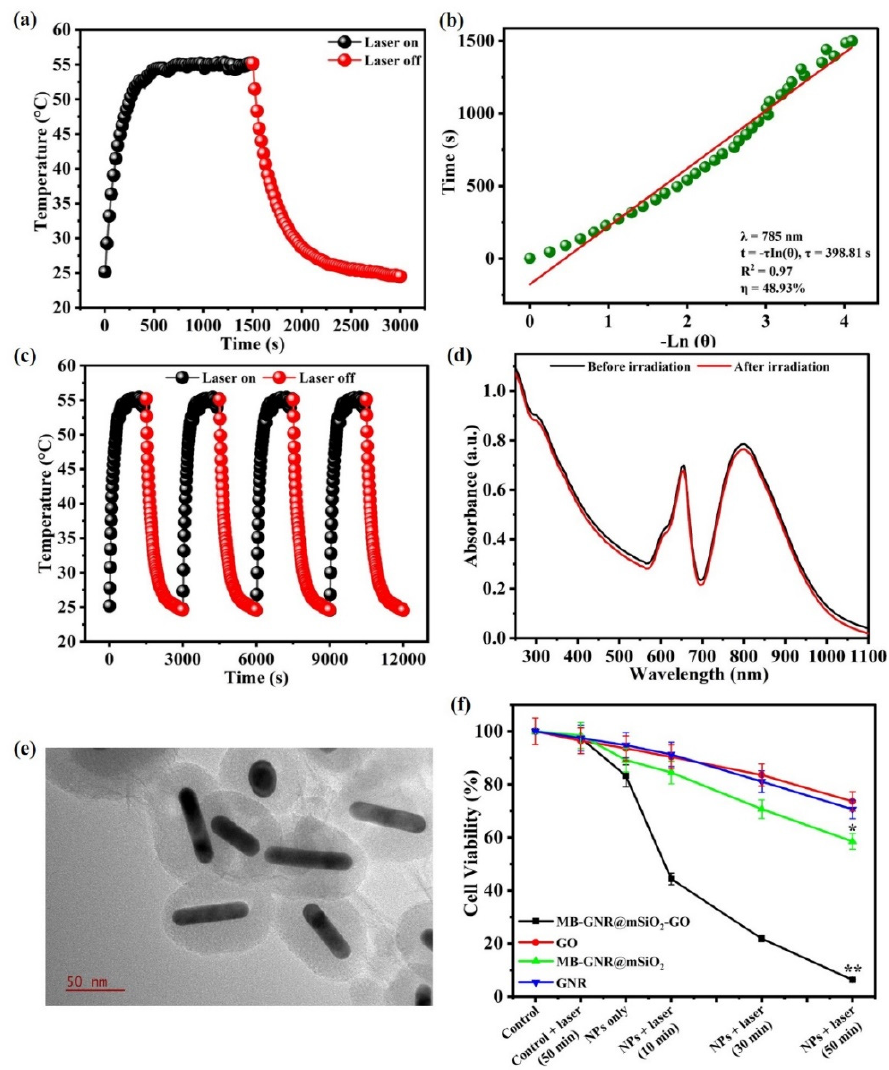
Figure 5. ( a ) The temperature variation curves of methylene blue-loaded mesoporous silica-coated gold nanorods on the graphene oxide (MB-GNR@mSiO 2 -GO) aqueous solution (200 µ L of 36 µ g/mL) under 785 nm laser irradiation at 0.8 W/cm 2 for 25 min, followed by natural cooling for 25 min. ( b ) The linear relationship of time data versus –In θ obtained from the cooling period of the panel. ( c ) The temperature variation curves of the MB-GNR@mSiO 2 -GO aqueous solution (200 µ L of 36 µ g/mL) under four 785 nm laser on/off cycles (0.8 W/cm 2 ). ( d ) UV–vis spectra of